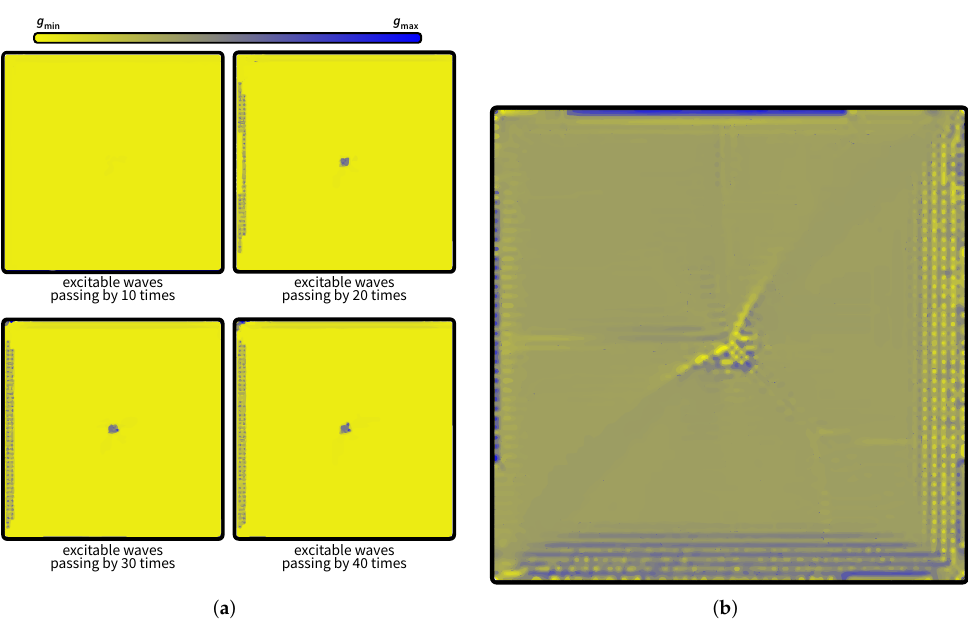
Figure 8. Conductance map of memristors for 2-D media for ocean-surface-wave patterns; ( a ) early and ( b ) late maps